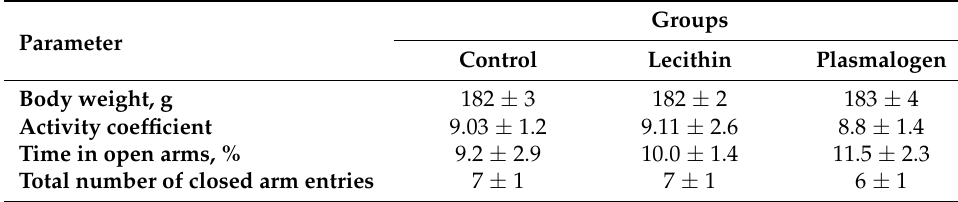
Table 5. Distribution of animals by